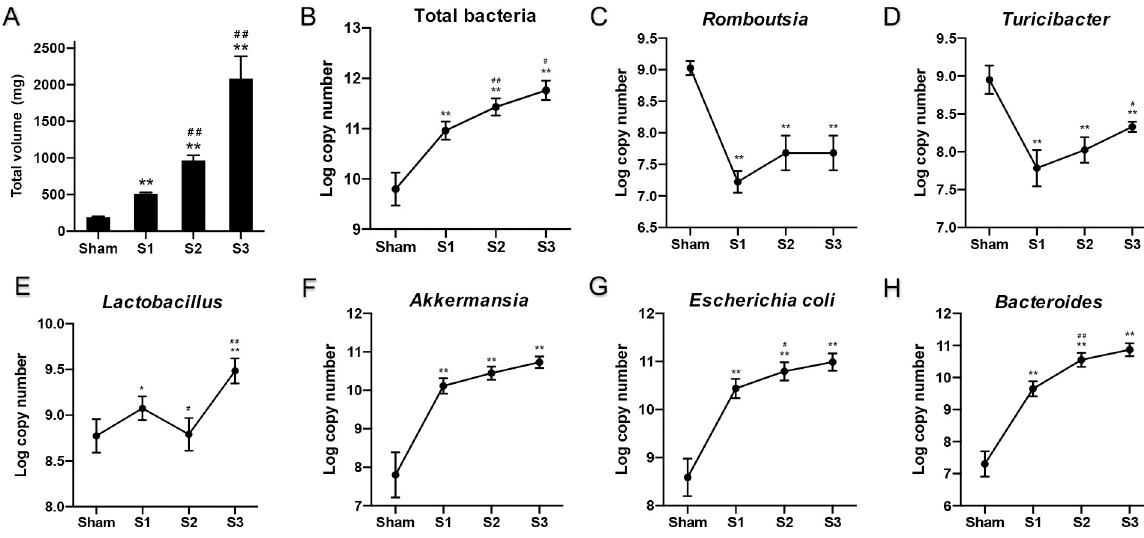
Fig 10. Total volume of fecal contents and changes in quantification of target bacterial groups with prolonged obstruction time. Data are presented as the mean ± SD, n = 5. � P < 0.05, �� P < 0.01 vs. Sham group; # P < 0.05, ## P < 0.01 vs. the preceding group.